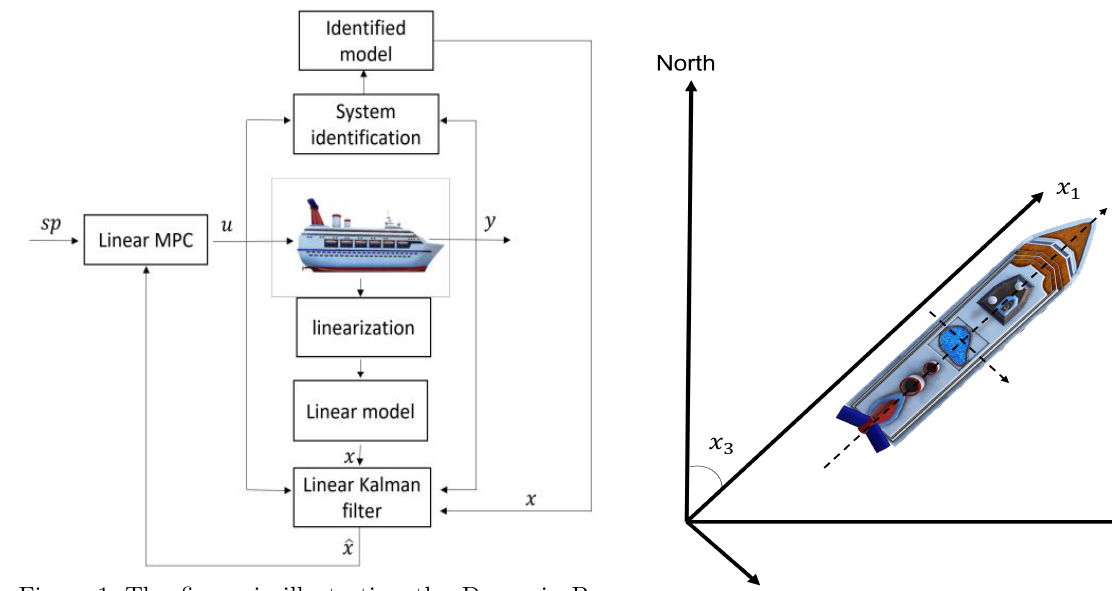
Figure 1: The figure is illustrating the Dynamic Po- sitioning control system with linear MPC, linear model and identified model. By ’linearization’-block it is assumed that a model is available describing the vessel dy- namics.